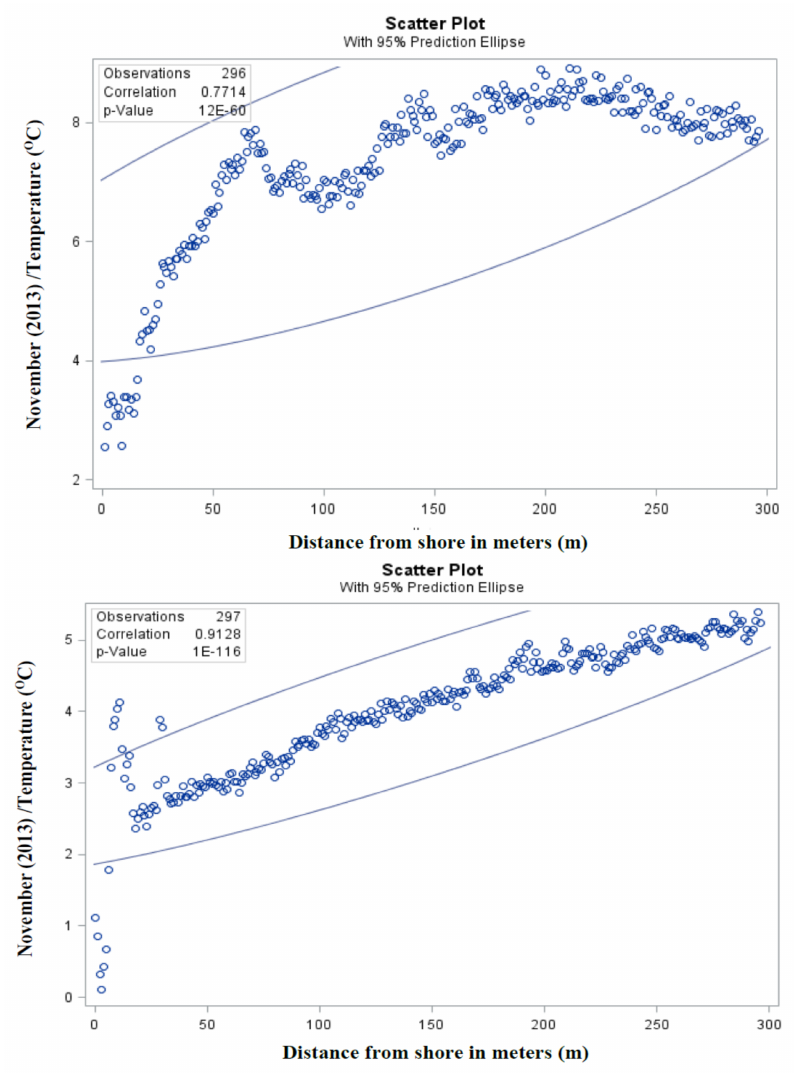
Figure 8. Plot showing Pearson’s correlation between November 2013 temperature and distances at Suvilahti in the city of Vaasa. Ketunkatu (above) and Liito-oravankatu (below). The meaning of p -value = 12E − 60 = 12 × 10 − 60 ( above ). The meaning of p -value = 1E − 116 = 1 × 10 − 116 ( below